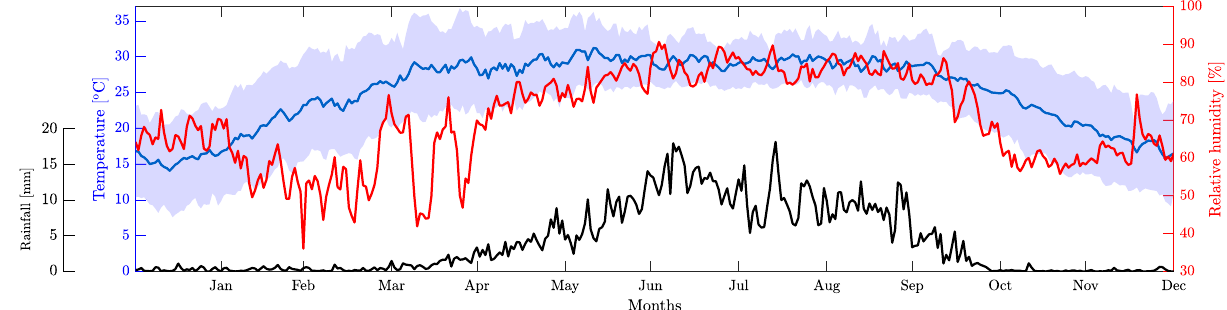
Figure 2. Time series plot (daily average) of the rainfall, temperature, and relative humidity over the study area from 1980 to 2018. The limits of shades in blue represent the maximum and minimum (temperature) values.